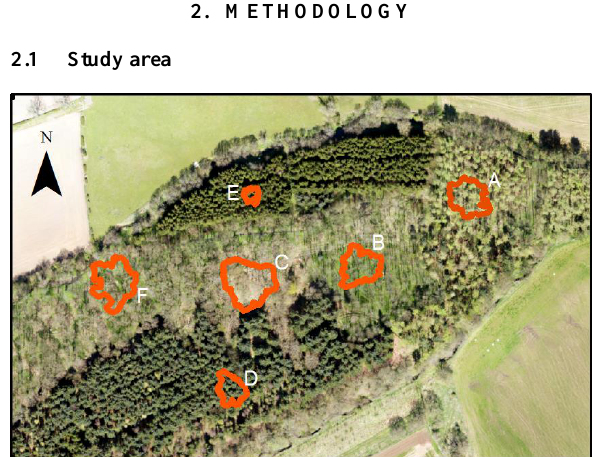
Figure 1. Aerial view of Hangingleaves Wood in Cockle Park Farm, Northumberland, with six plots: A – European larch, B – Sycamore, C – English oak, D – Sitka spruce, E – Norway spruce, F-